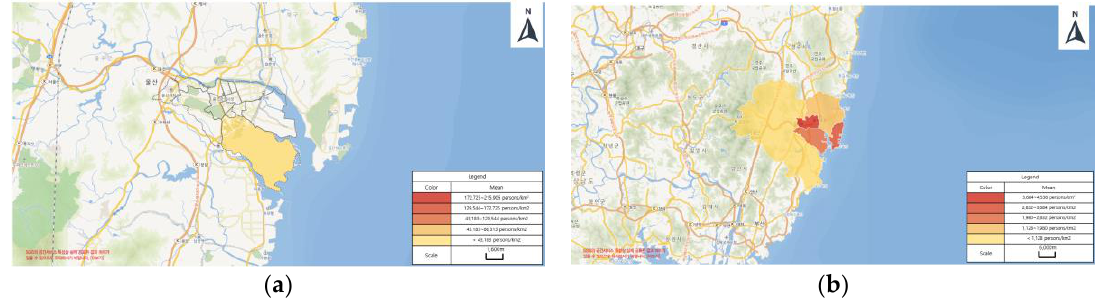
Figure 2. The population density: ( a ) Ulsan industrial complex (43,183 persons/km 2 ); ( b ) Ulsan average density (1099 person/km 2 ). Table 11. Number of people expected to be prepared for an accident.